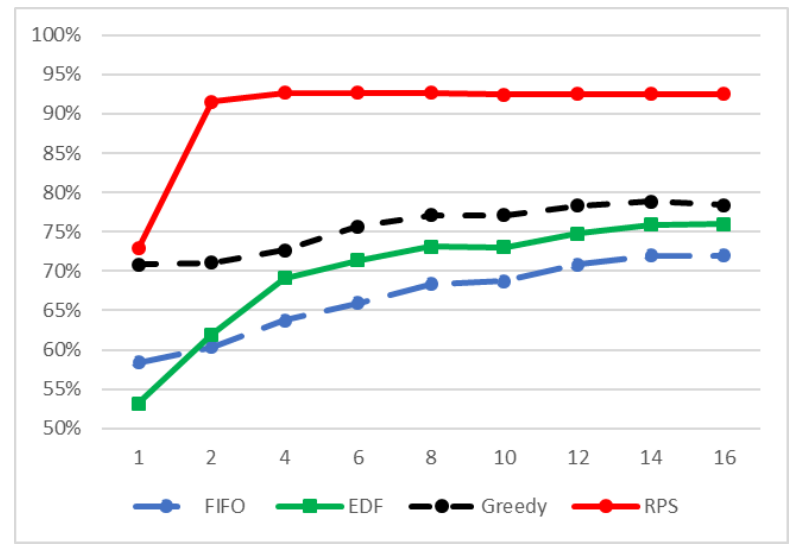
Figure 6. Percentage of delivered packets with different window sizes ( λ a = 56,000).